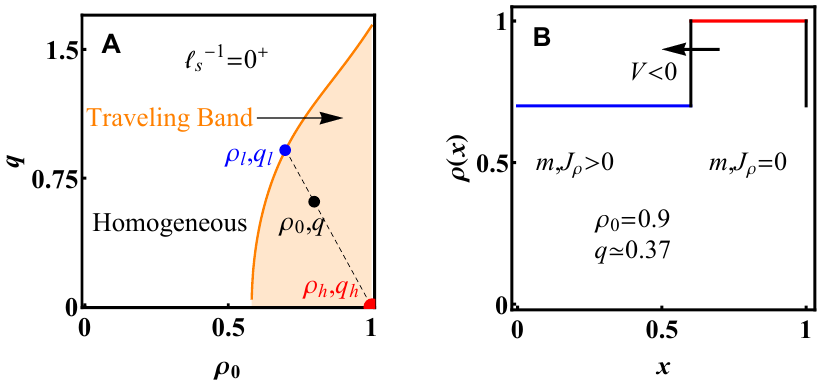
Figure 5: (A) The phase diagram for current fluctuations q at Pe = 3.5. The orange curve marks the boundary between the traveling band phase and a homogeneous → ∞ . It is given in a parametric form by Eqs. (33) and (25). The dashed phase at ℓ s line denotes the convex hull construction between the high density phase which is = 1, q = 0 ) , and the low density phase. It is given by always at close packing ( ρ 0 the intersection of this line with the orange curve denoting the edge of the traveling band phase. (B) An instance of the traveling band solution that corresponds to the geometrical construction illustrated in panel (A). As discussed in Sec. 6, the sharp interface is smoothed at finite ℓ s